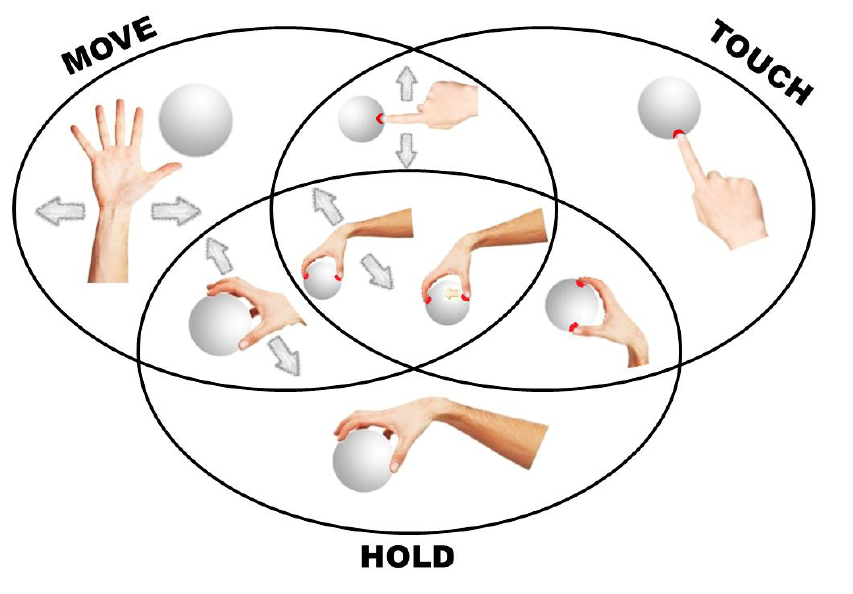
Figure 3. Taxonomy of move, hold and touch